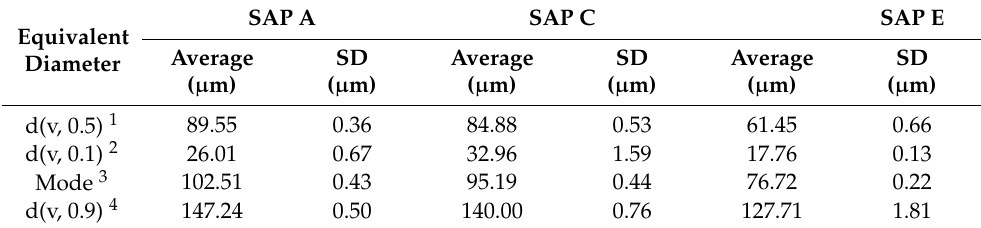
Table 3. Particles size features of